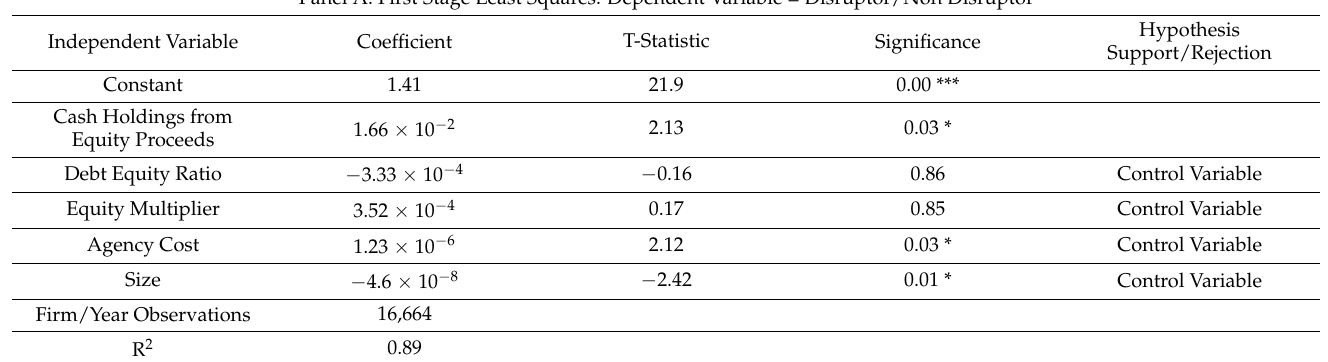
Table 5. Two-Stage Least Squares Regressions of Cash Holdings from Equity Proceeds on Disruption, Followed by Disruption on Financial Performance (Full Sample). Panel A: First Stage Least Squares: Dependent Variable = Disruptor/Non Disruptor